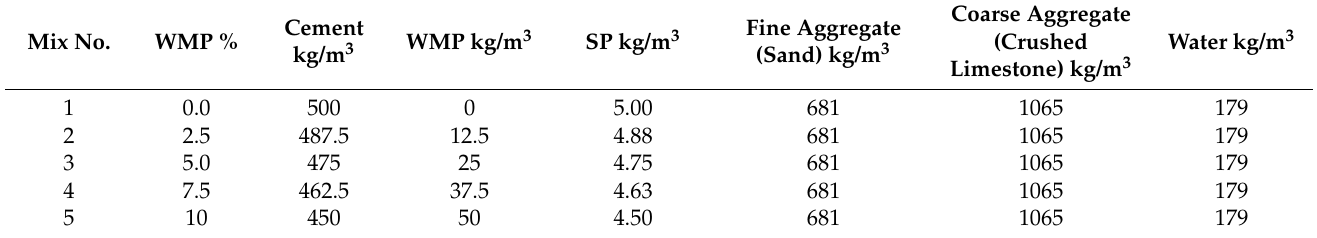
Table 4. Concrete mixes’